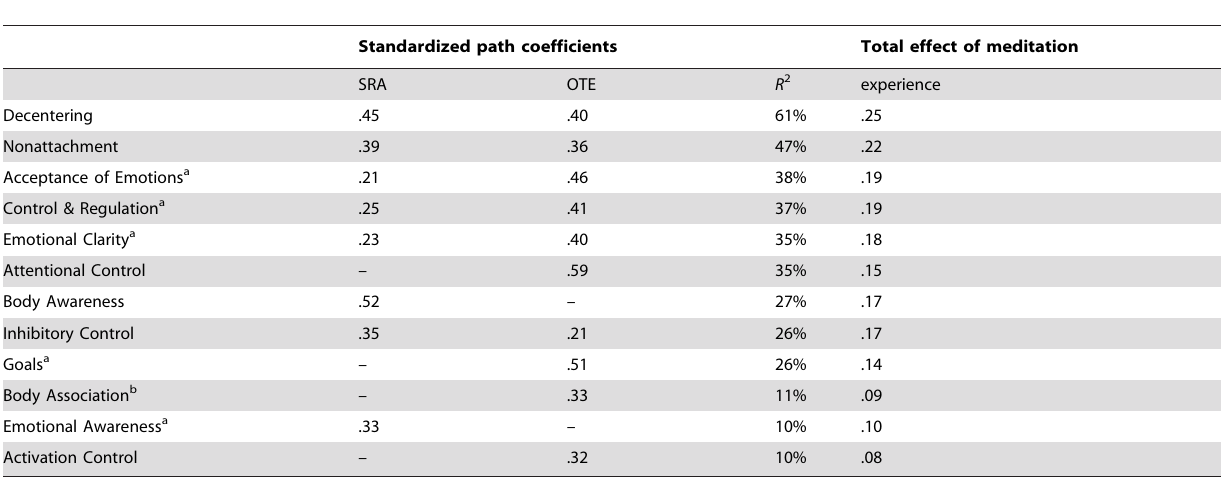
Table 7. Mechanisms of Mindfulness in Descending Order of Explained